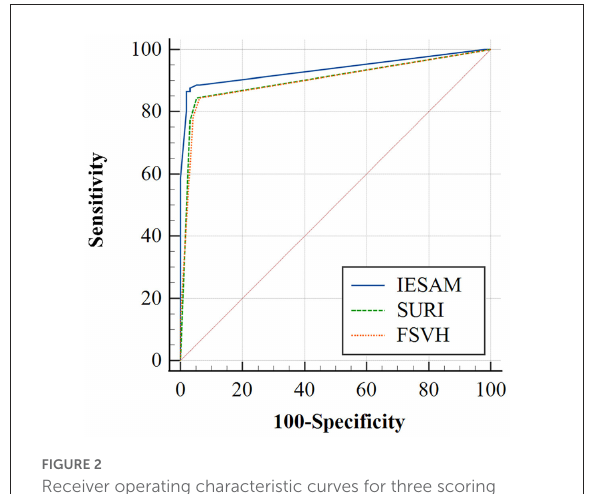
FIGURE2 Receiver operating characteristic curves for three scoring methods of endolymphatic hydrops with definite Ménière’s disease.